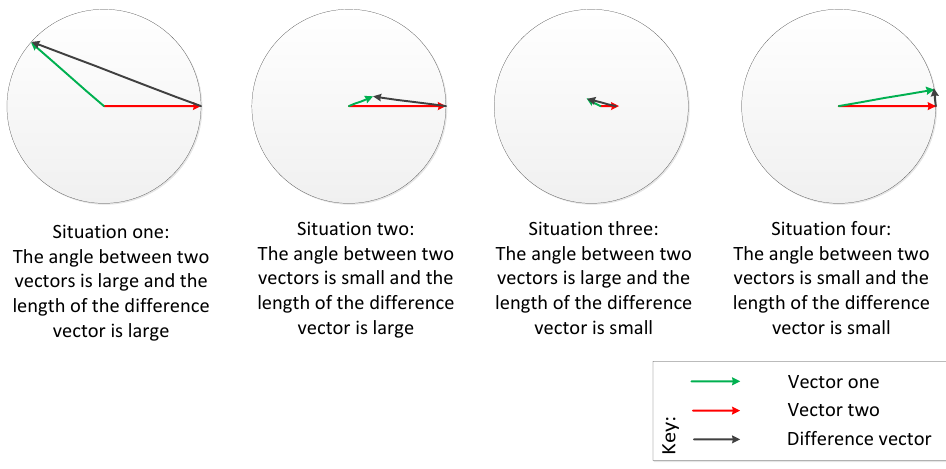
Figure 7. State graph of vector cosine and vector